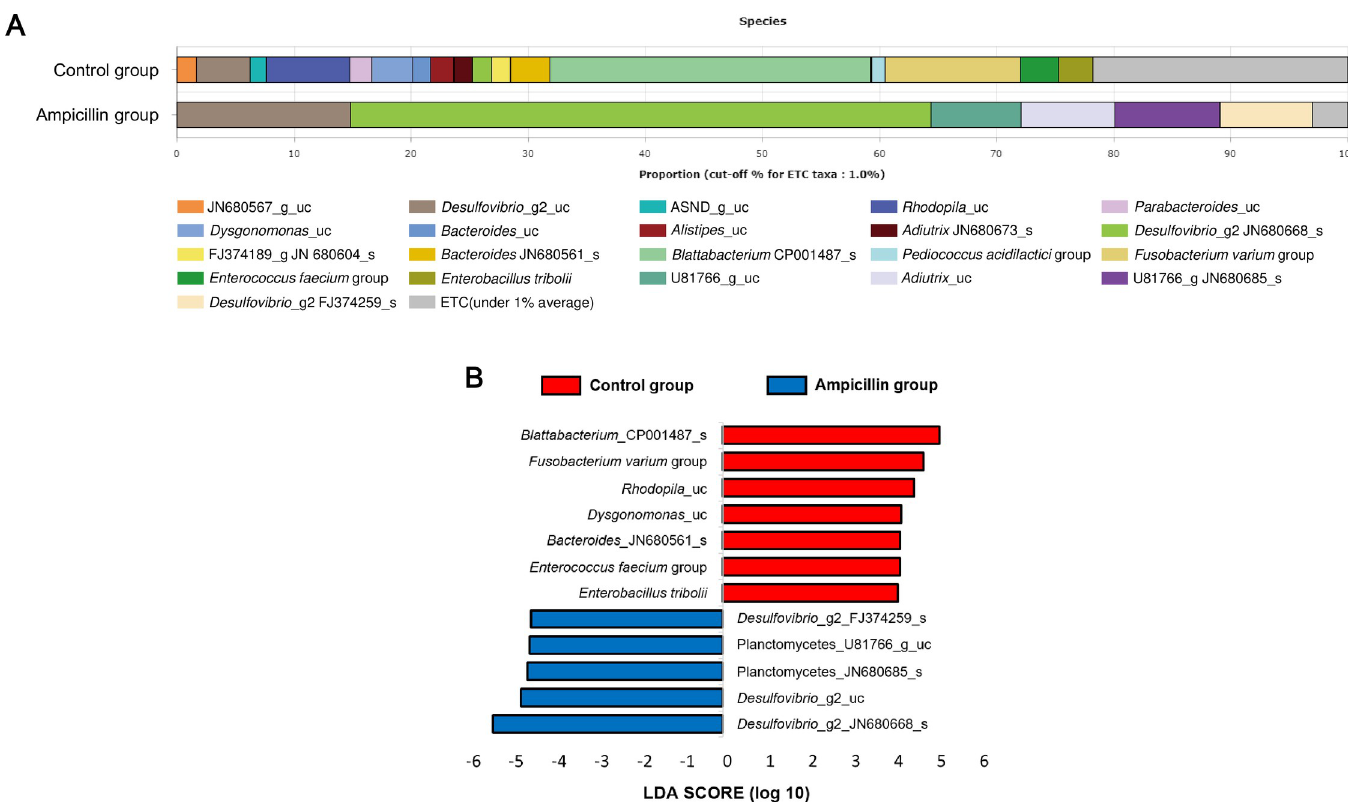
Fig 3. Bacterial composition at the species level in the control and ampicillin-treated groups. (A) Microbiome composition of each group (n = 5). (B) Linear discriminant analysis effect size analysis of differentially abundant bacterial taxa among the two groups. Only taxa meeting a significant ( > 4) linear discriminant analysis threshold are